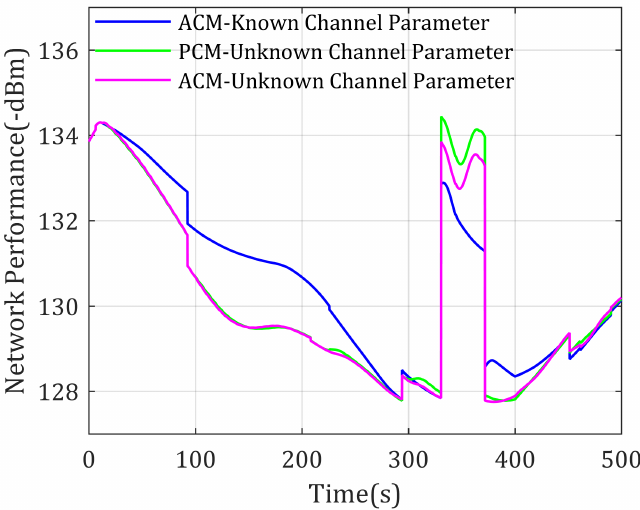
Figure 17. Network performance for multi-mobile-agents-inter communication with unknown channel